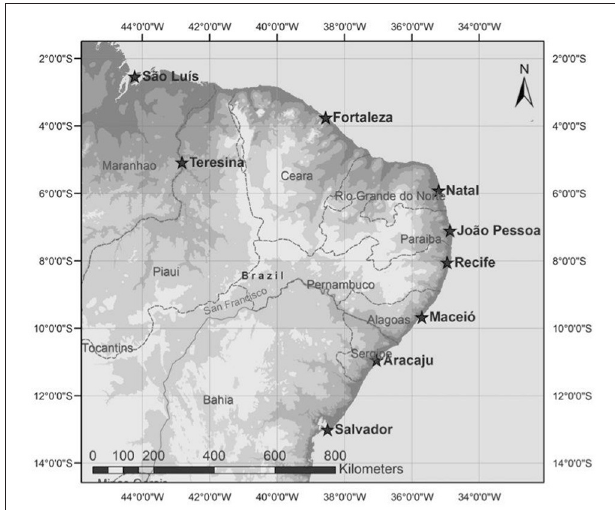
FIGURE 1 | The national states and its corresponding capitals of northeastern